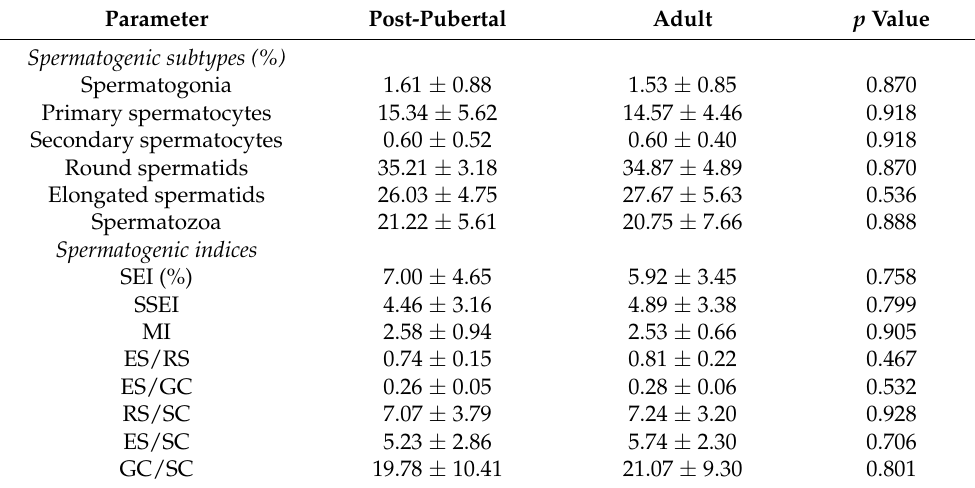
Table 2. Percentage of spermatogenic cell subtypes and indices in <1-year-old (post-pubertal, n = 9) and >1-year-old (adult, n = 7) sexually mature